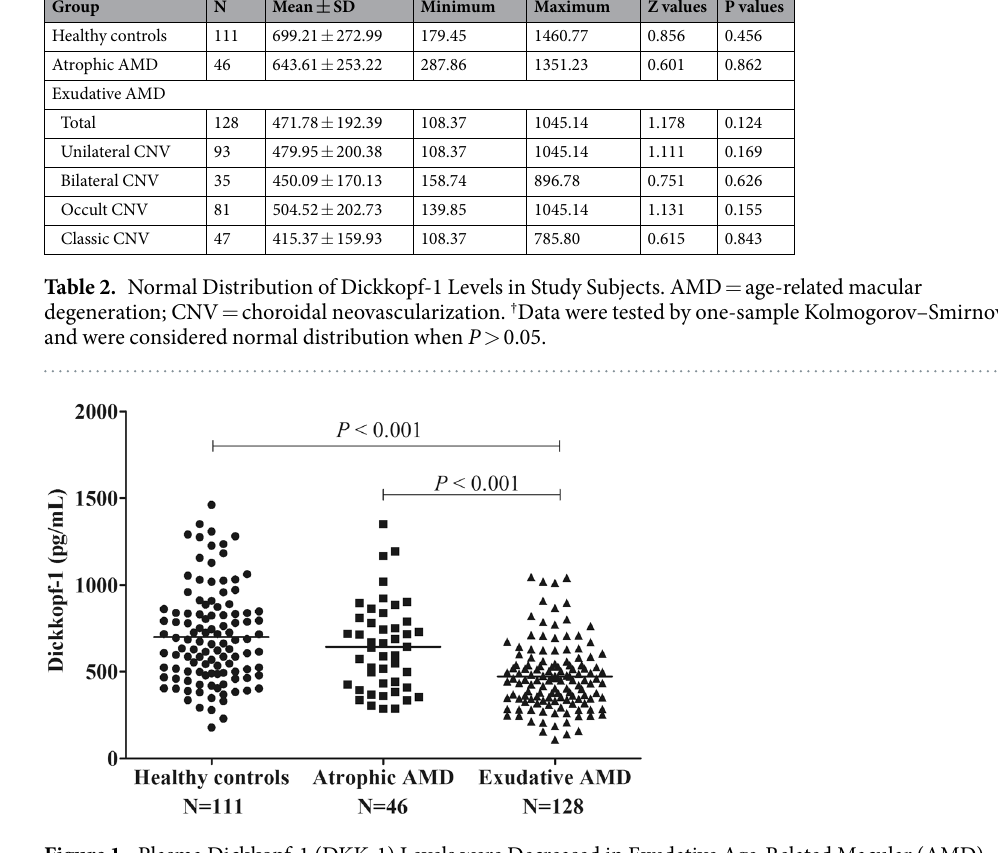
Figure 1. Plasma Dickkopf-1 (DKK-1) Levels were Decreased in Exudative Age-Related Macular (AMD), Compared with Healthy Controls and Patients with Atrophic AMD. Analysis was performed by one-way analysis of variance with post hoc Tamhane tests. Each spot represents one patient. Middle lines represented the